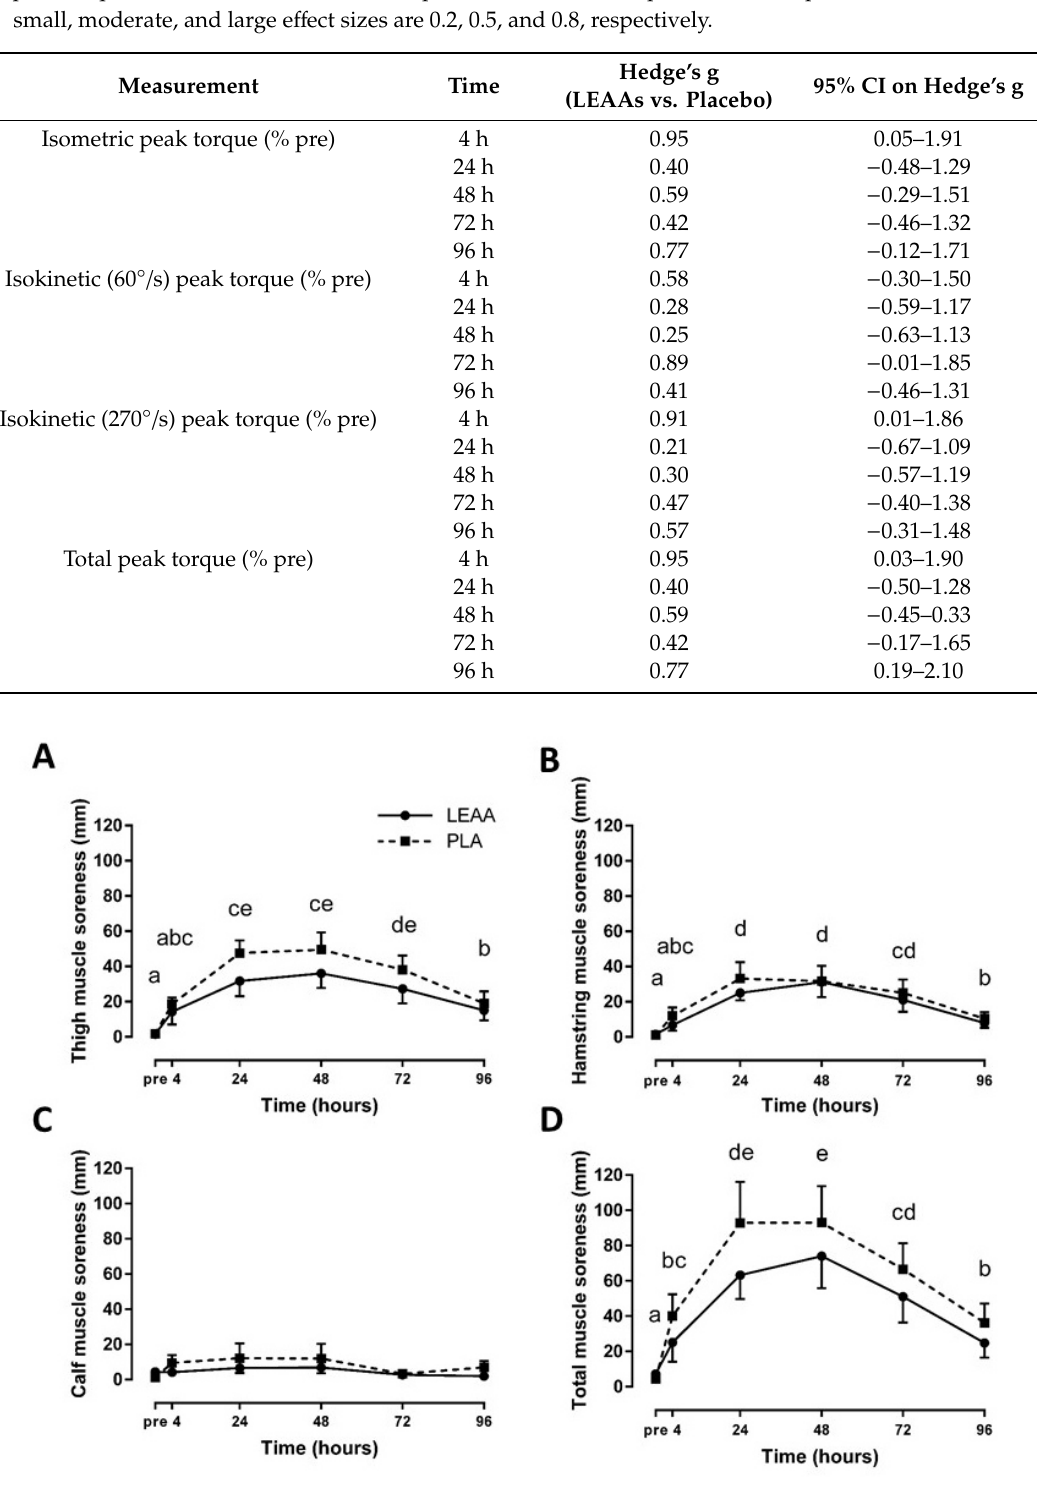
Figure 4. Mean ( ± SEM) thigh ( A ), hamstring ( B ), calf ( C ), and total ( D ) ratings of perceived muscle soreness after resistance exercise in response to LEAA or placebo consumption. Time points with different letters are significantly different from each other (main effect for time, p < 0.05). Pre, pre‐exercise; PLA, placebo.